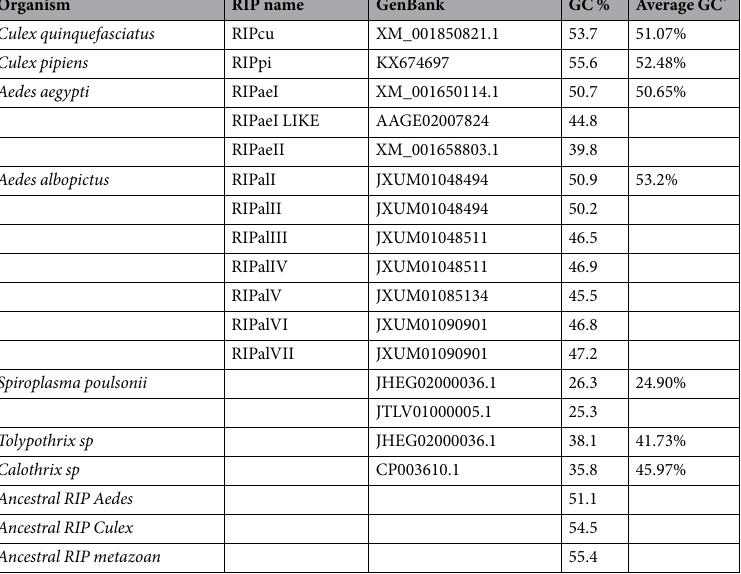
Table 1. GC content analysis. The GC content of RIP genes was calculated using DNA/RNA GC Content Calculator (http://www.endmemo.com/bio/gc.php). * The average of GC content in coding regions was obtained from the codon usage database